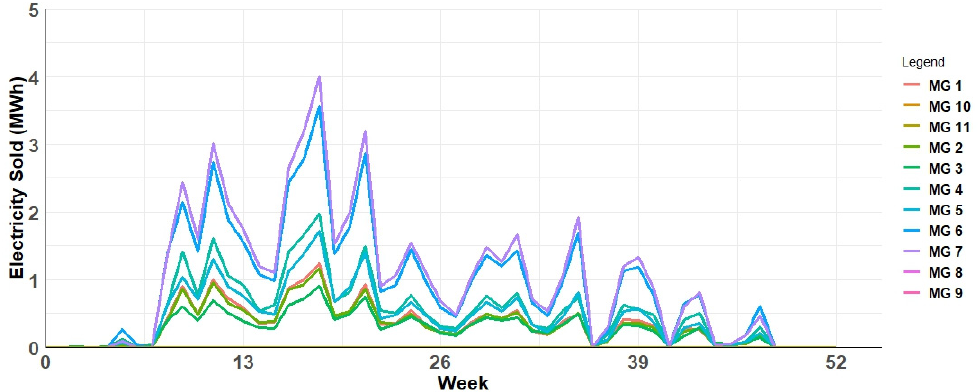
Figure 10. Weekly wind energy (Mwh) generated at each microgrid over a one-year time period.